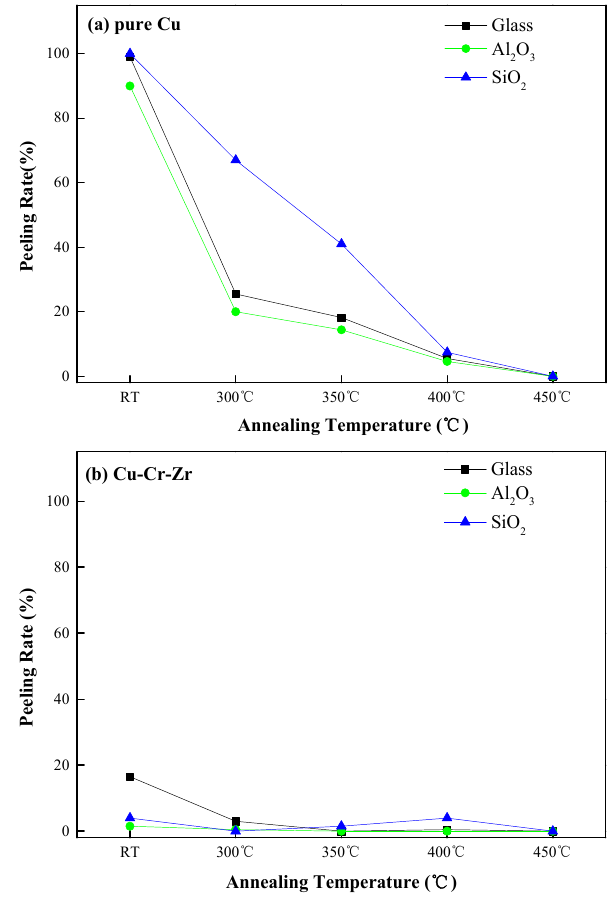
Figure 3. Adhesion on various substrates at different annealing temperatures with the contrast of Cu/Ti on glass: ( a ) pure Cu; ( b ) Cu-Cr-Zr. Table 3. The grades of Cu-Cr-Zr thin film adhesion on various substrates.